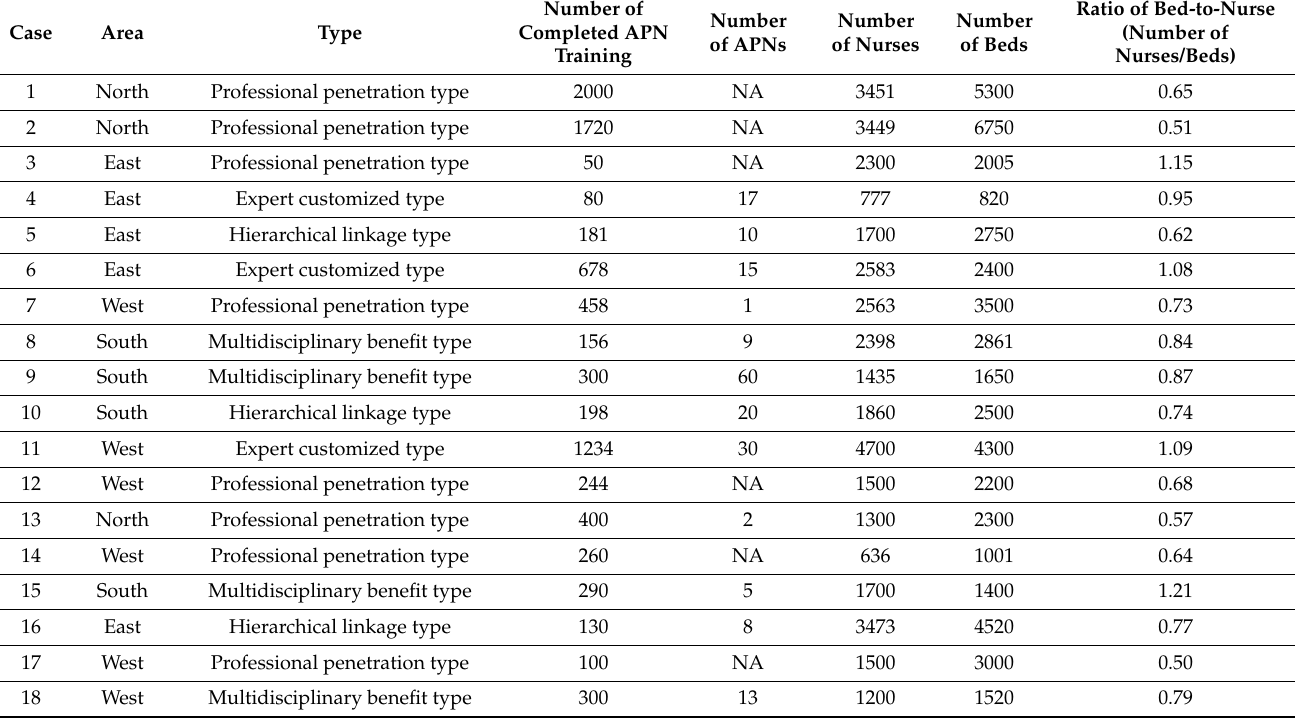
Table 2. Resource data from 18 cases